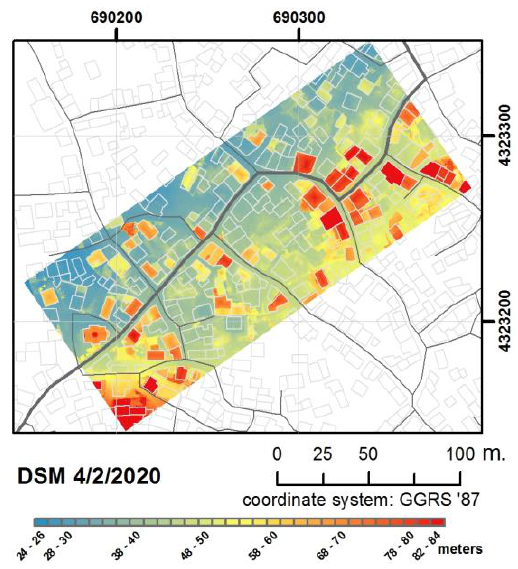
Figure 4. DSM (4.38 cm/pix) derived from the second flight of 40 m